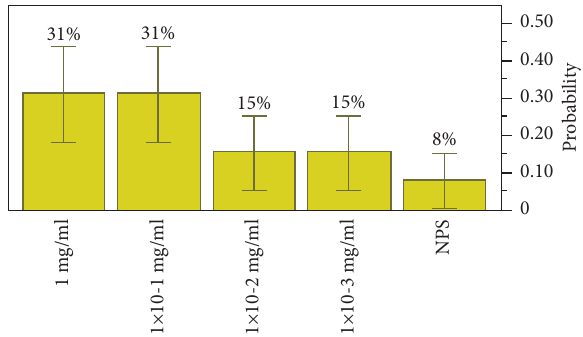
Figure 4: Distributions and test probabilities of extract D on target organisms.